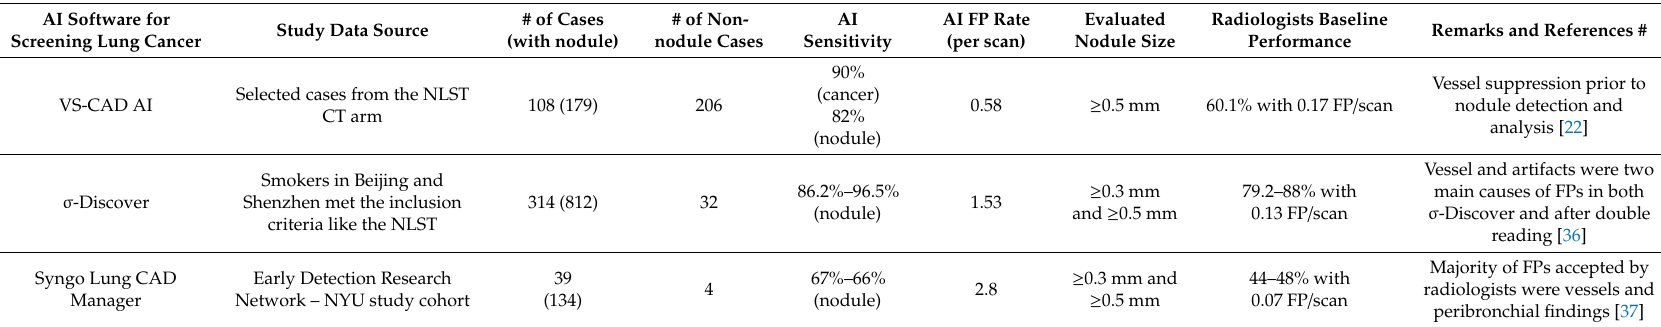
Table 3. Parameters and performance of three commercially available artificial intelligence (AI) systems for the detection of lung nodules on thoracic CT. AI Software for Screening Lung